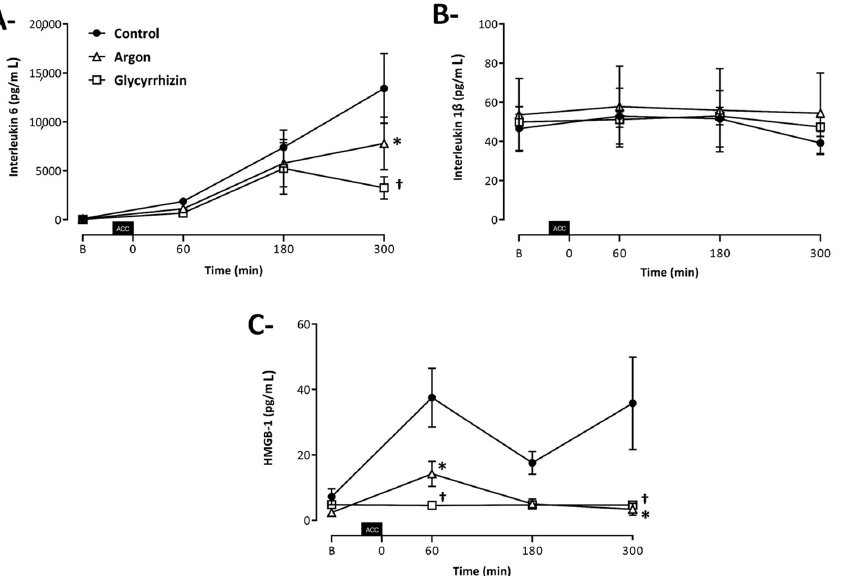
Figure 4. Blood levels of interleukin 6 ( A ), interleukin 1 ( B ) and High Mobility Group Box 1 ( C ). ACC: Aortic cross clamping; * p < 0.05 between Control and Argon; † p < 0.05 between Control and Glycyrrhizin; Control ( n = 7), Argon ( n = 7), Glycyrrhizin ( n = 7).